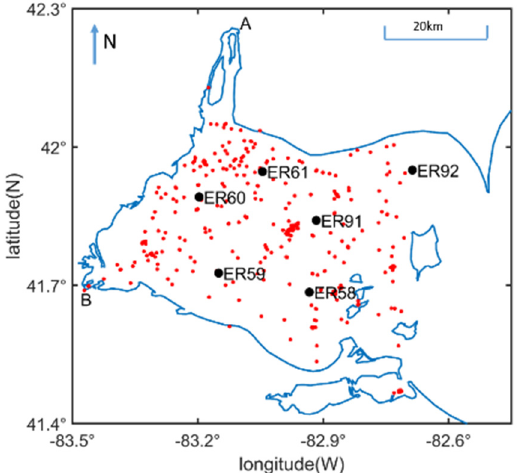
Figure 1. Map of Lake Erie and data sites. Detail of western basin shoreline showing the Detroit River (A), Maumee River (B), NOAA (red dots), and GLENDA (black dots).